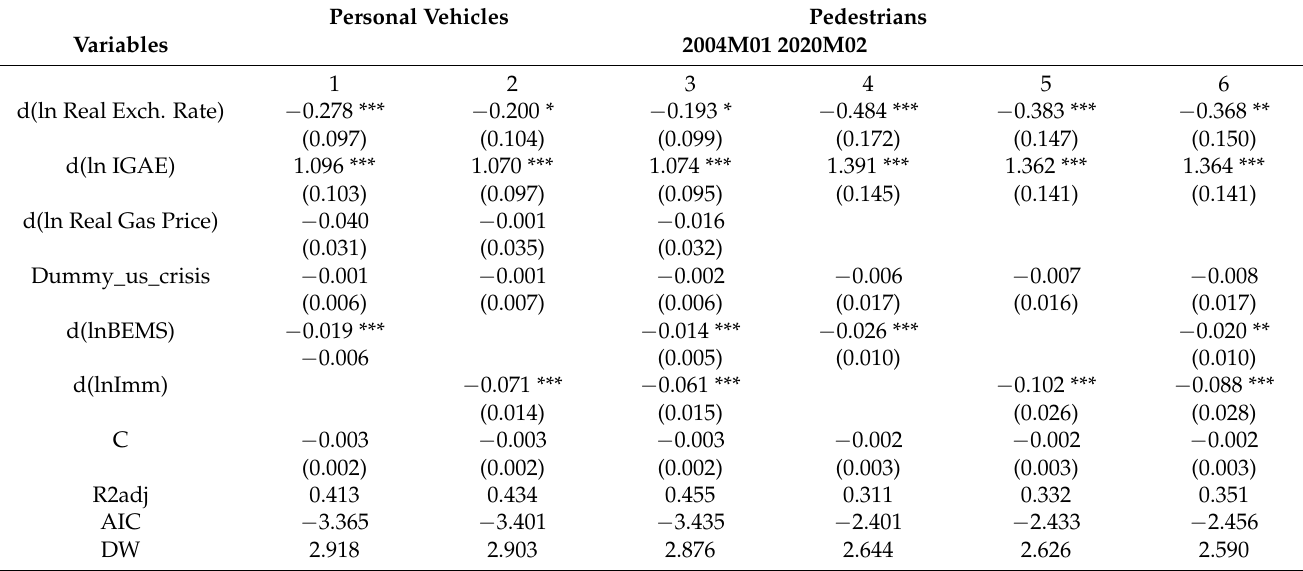
Table 5. Personal vehicles and pedestrians OLS estimations (period: